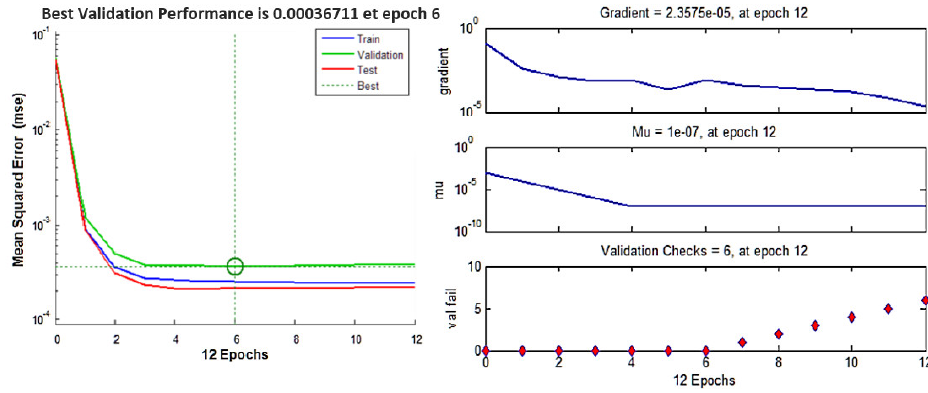
Figure 21. Training state and performance of the generated NN3 model for TCU.